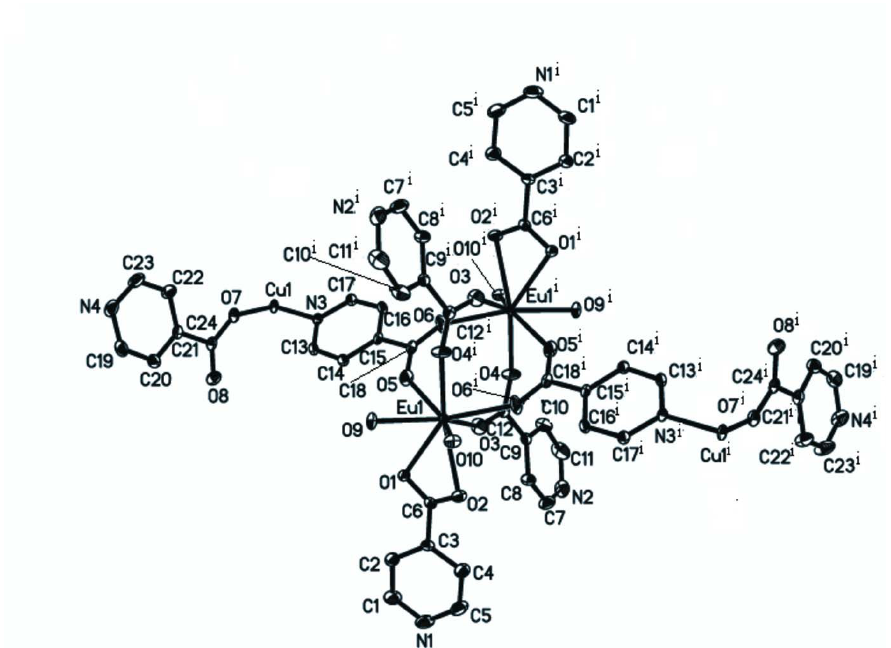
Figure 1 The ORTEP - 3 (Farrugia, 1997) drawing of the title compound. Displacement ellipsoids are drawn at 30% probability level. Symmetry codes: (i) - x + 1, - y + 2, - z